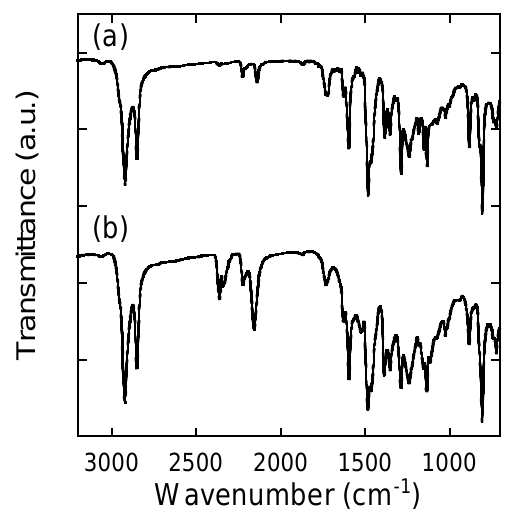
Figure 3. IR spectra (neat) of ( A ) P1 and ( B ) P2